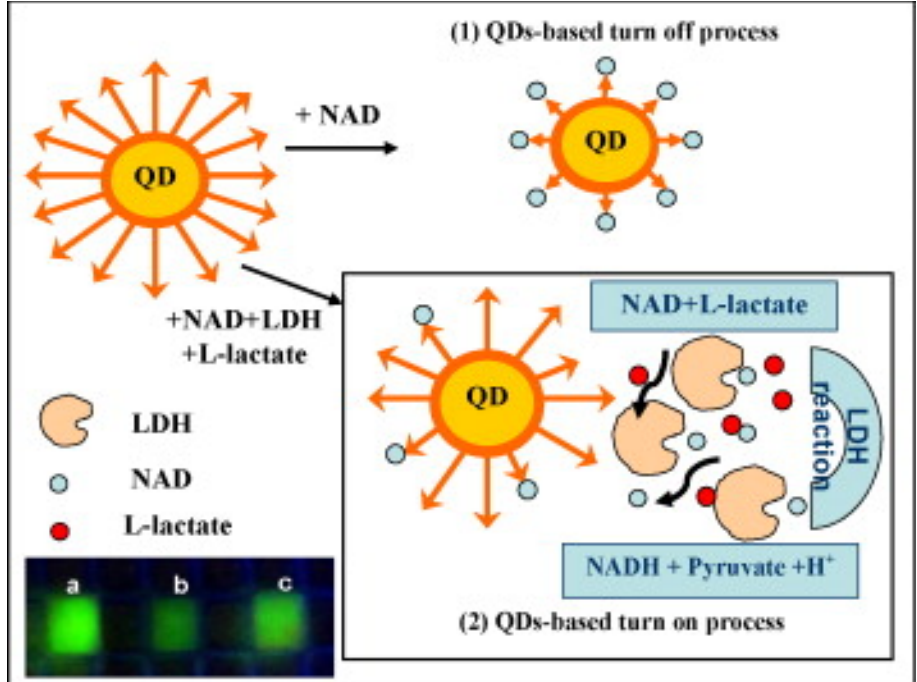
Figure 6. Schematic diagram of the principle of LDH determination, with the lower left panel showing the fluorescence image of the QDs in the absence ( a ) or presence ( b ) of NAD, and in the presence of LDH, NAD and LL ( c ) [86]. Copyright 2010 Elsevier.